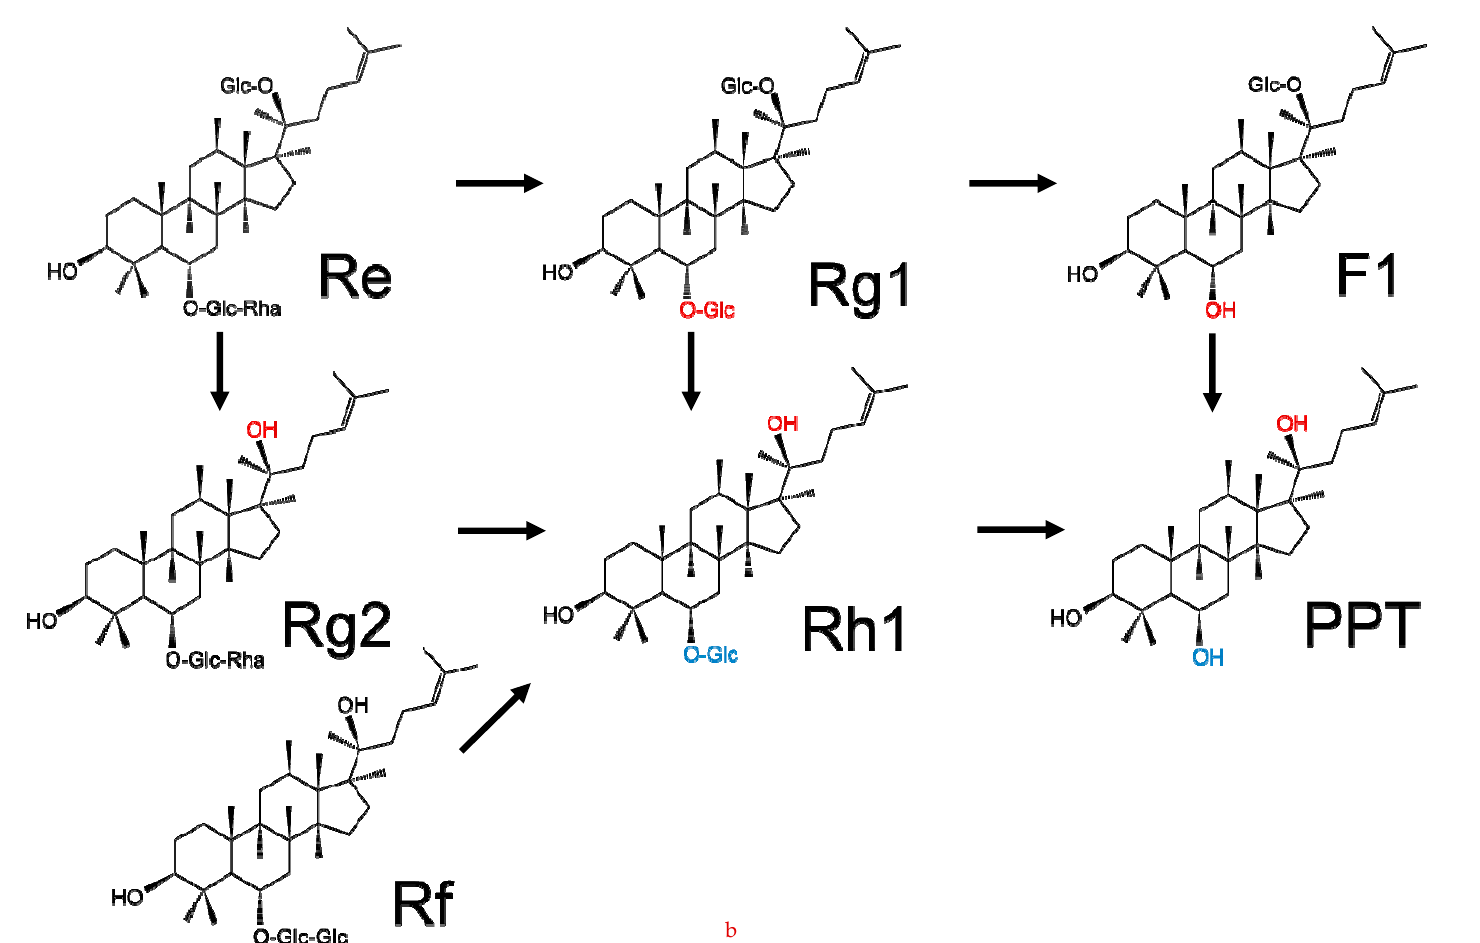
Figure 2. Main metabolic processes of ( a ) 20( S )-protopanaxadiol- and ( b ) 20( S )-protopanaxatriol-type ginseng saponins. The changed carbohydrate moieties are highlighted in red. For the daughter ginseng saponin comes from two di ff erent parental ginseng saponins, one of the changed carbohydrate moieties is highlighted in red and the other is highlighted in